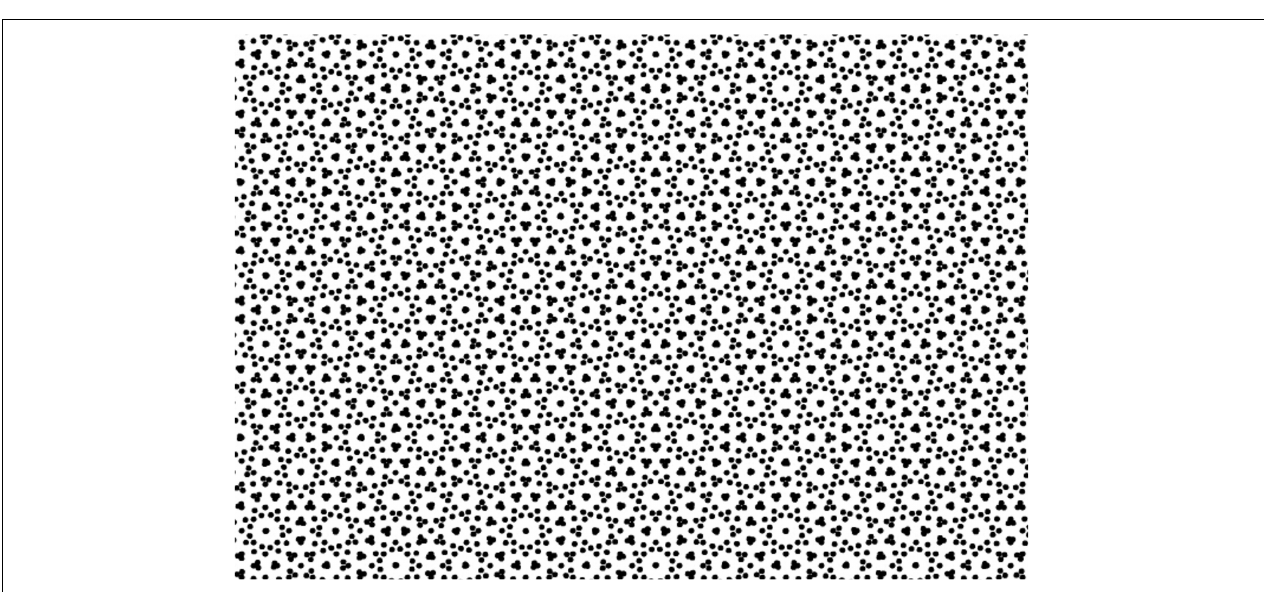
FIGURE 12 | Depiction of the stimulus and aftereffect of the dynamic twinkle paradigm (From Tyler and Hardage, 1998). (A) Achromatic twinkle > 12 Hz. The aftereffect appears as twinkling noise in the unstimulated region (which does not exhibit filling in at this scale). (B) Purely chromatic twinkle evokes no aftereffect. This is a dynamic illusion of fiction of visual signals.